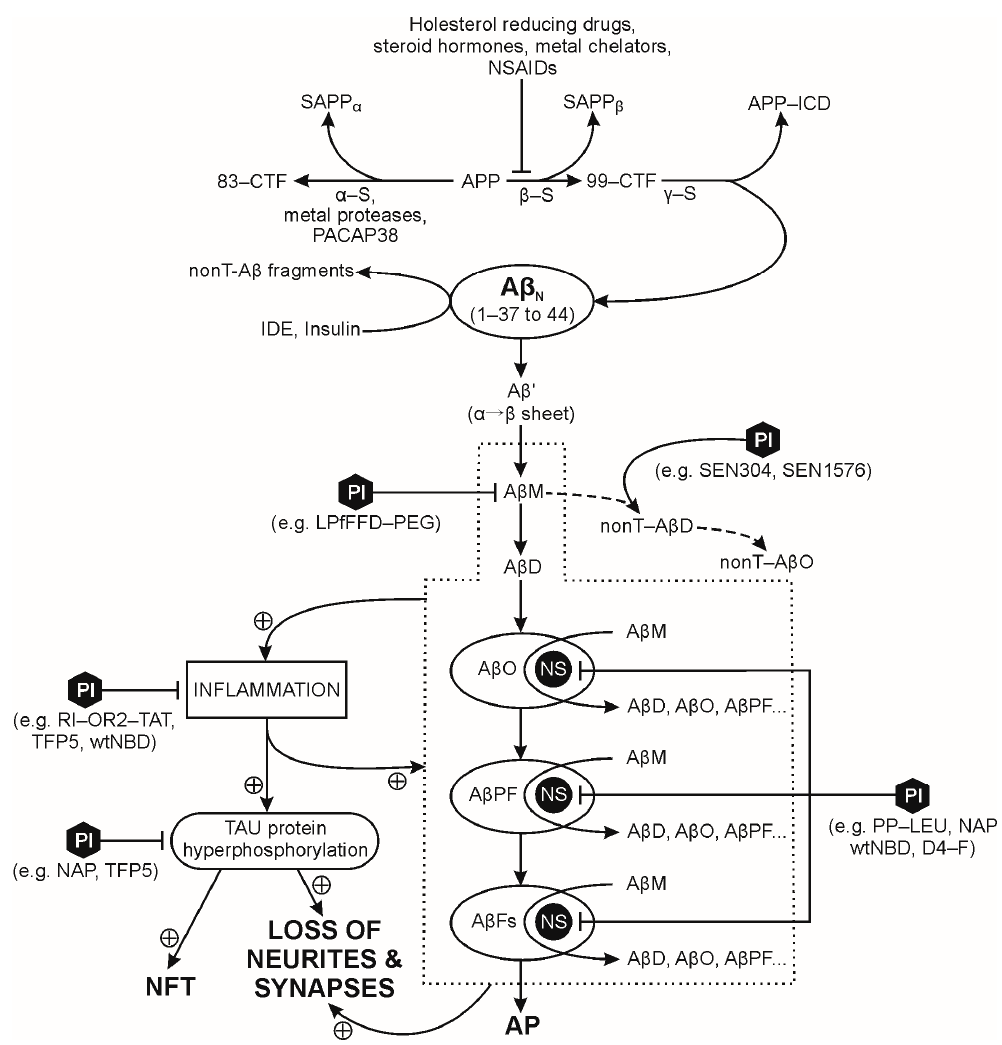
Figure 1. Pathways of amyloid precursor protein proteolysis, amyloid plaque formation and targets of selected peptide inhibitors. Abbreviations: 83-CTF (83-amino acid membrane bound C-terminal fragment); 99-CTF (99-amino acid membrane bound C-terminal fragment); AP (amyloid plaque); APP (amyloid precursor protein); APP-ICD (APP intracellular domain); A β′ (misfolded A β peptide with first α -sheet, then β -sheet structure); A β n (native A β peptide with α -helix structure); A β D (amyloid β dimer); A β Fs (amyloid β fibrils); A β M (amyloid β monomer); A β O (amyloid β oligomer); A β PF (amyloid β protofibril); IDE (insulin degrading enzyme); NFT (neurofibrillary tangles); nonT-A β D (non-toxic amyloid β dimer); nonT-A β O (non-toxic amyloid β oligomer); NS (nucleation site);